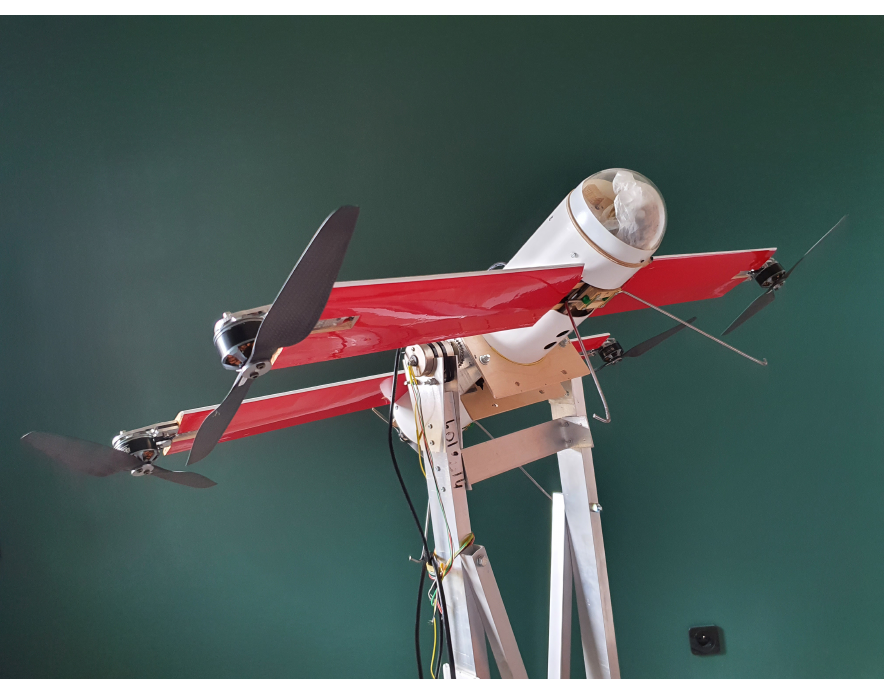
Figure 1. The Elka1Q drone.